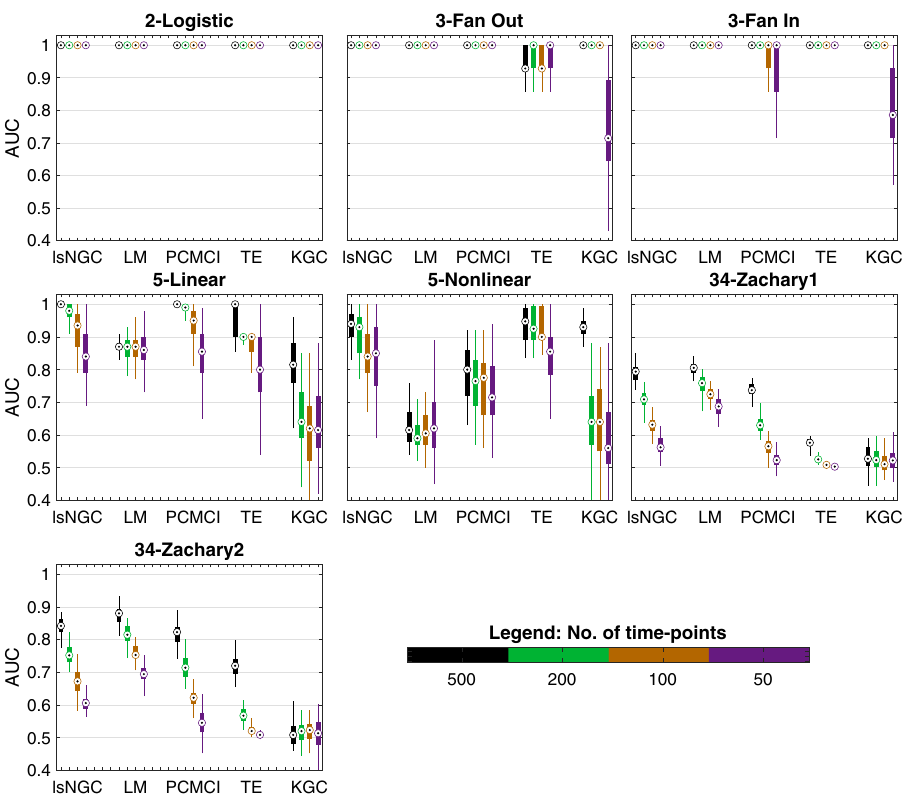
Figure 6. Effect of time-series length on performance. We observe that for large networks, KGC and TE do not perform well. LsNGC, on the other hand, performs well for all networks. The results are visualized as boxplots. The bottom end of the box represents the first quartile and the top of the box represents the third quartile. The circle with a dot in the box represents the distribution median. Generated with MATLAB R2016a 40